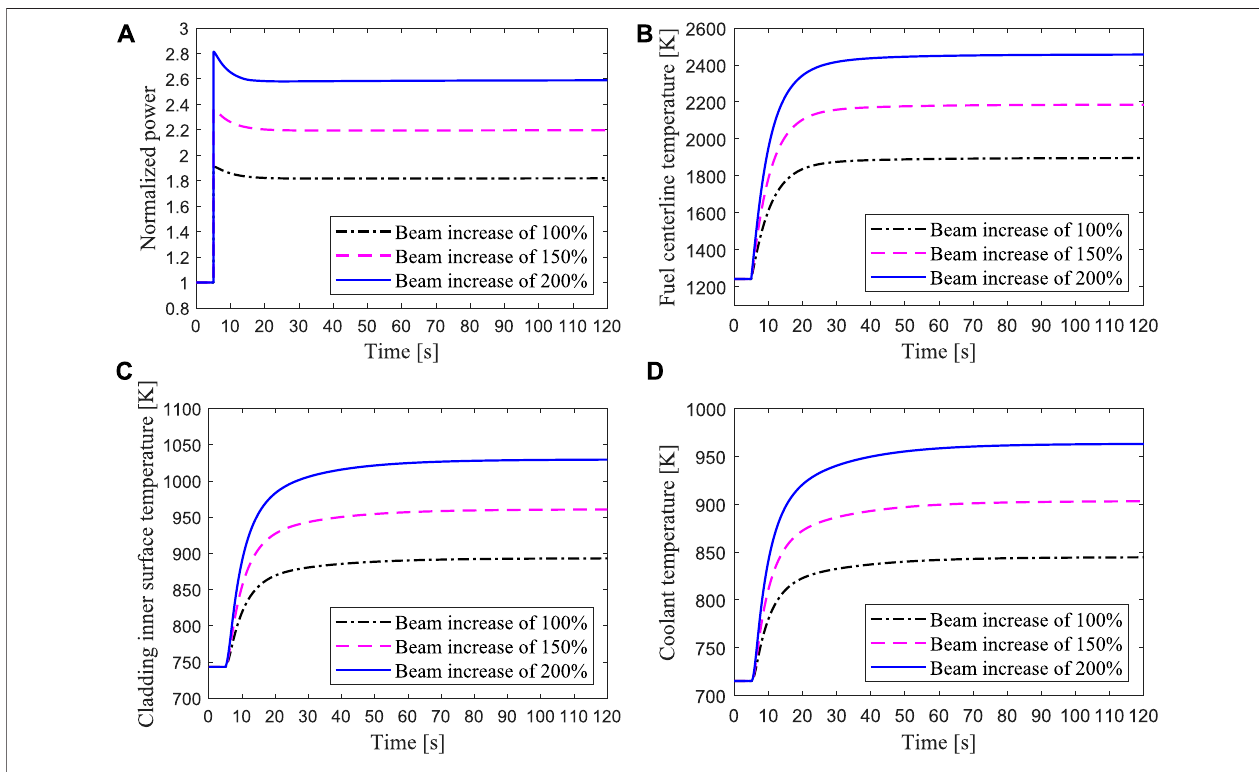
FIGURE 10 | Transient responses of the hottest channel when the intensity of proton beam increased by 100, 150, 200% respectively.